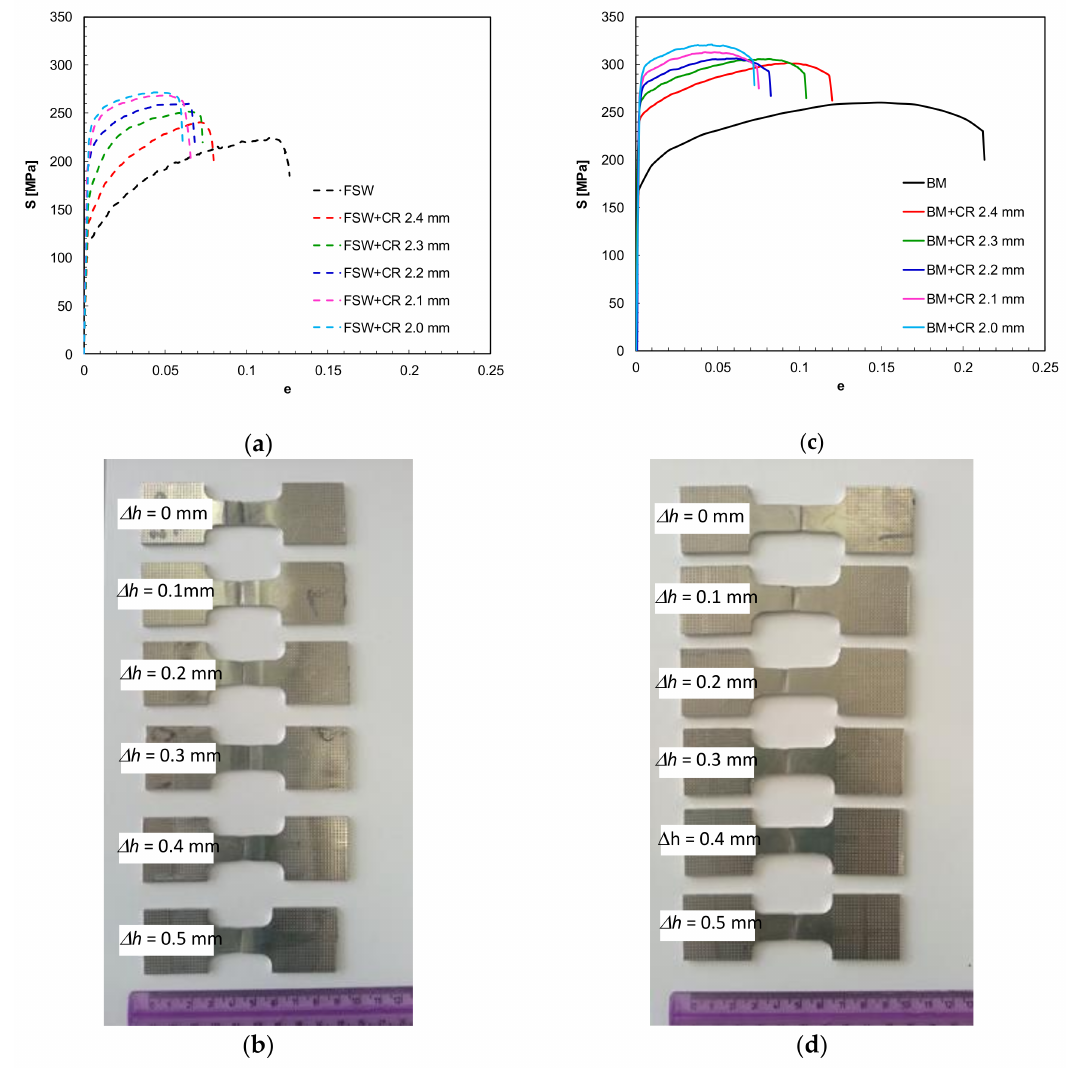
Figure 2. Typical nominal stress vs. nominal strain curves and fractured tension tested samples: ( a ) S-e curves and ( b ) fractured samples in the FSWed+CRed condition; ( c ) S-e curves; and ( d ) fractured samples in the BM+CRed